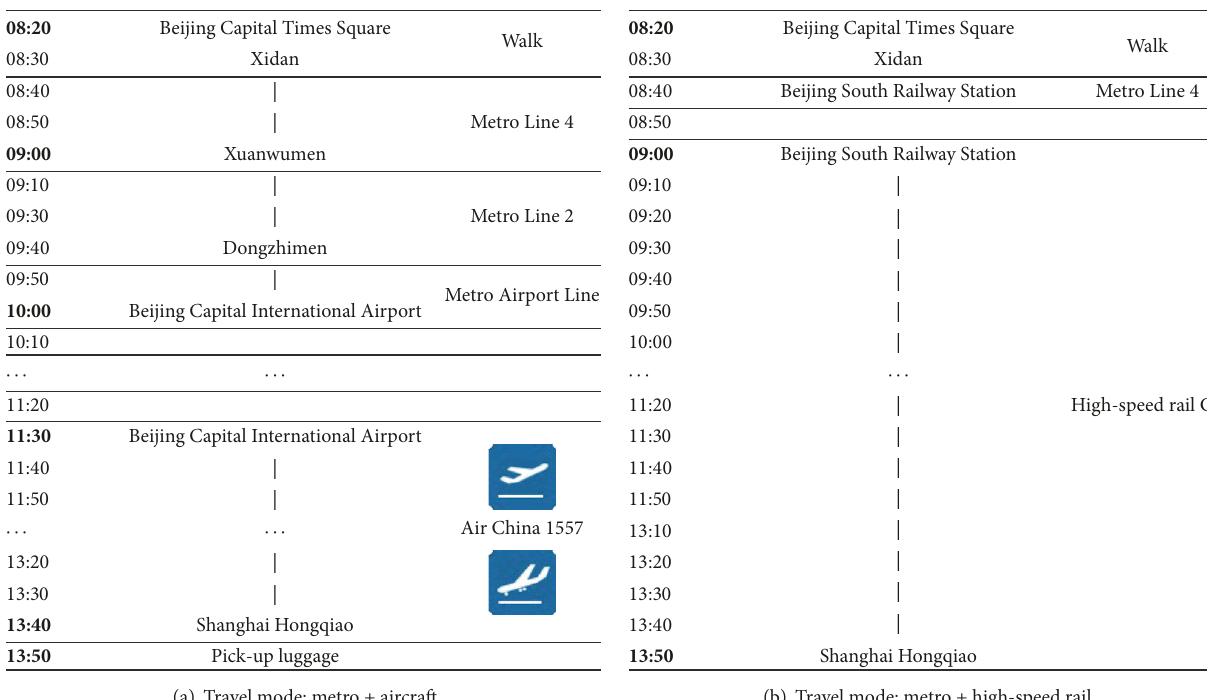
Figure 1: Comparison of air transportation and high-speed rail for a trip from Beijing Capital Times Square to Shanghai Hongqiao in China. Despite the large spatial distance of more than 1,200km, passengers using either mode arrive approximately at the same time in Shanghai. This example highlights the substantially different competition range between both modes, compared to the standard values for other regions around the world (often 200–300